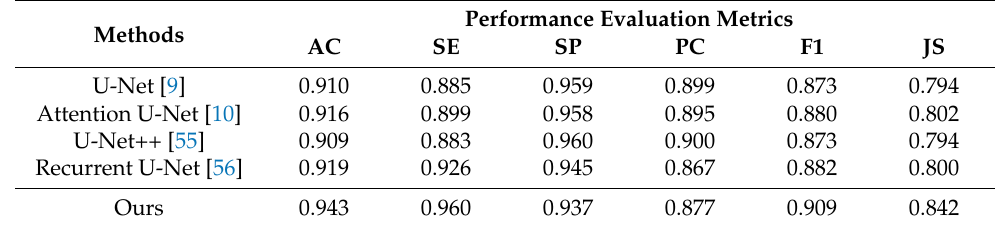
Table 4. Performance comparison of the proposed network and other methods on the PH2 dataset.